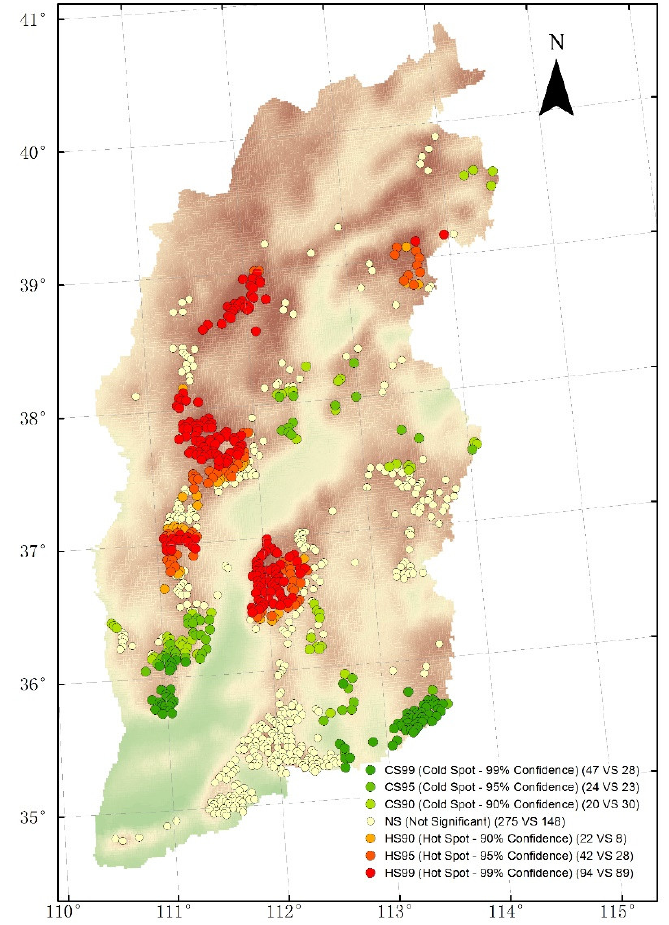
Figure 4. Map showing the spatial cold and hot spots of biomass carbon density in Shanxi, China. The number in parentheses is the number of sample plots.